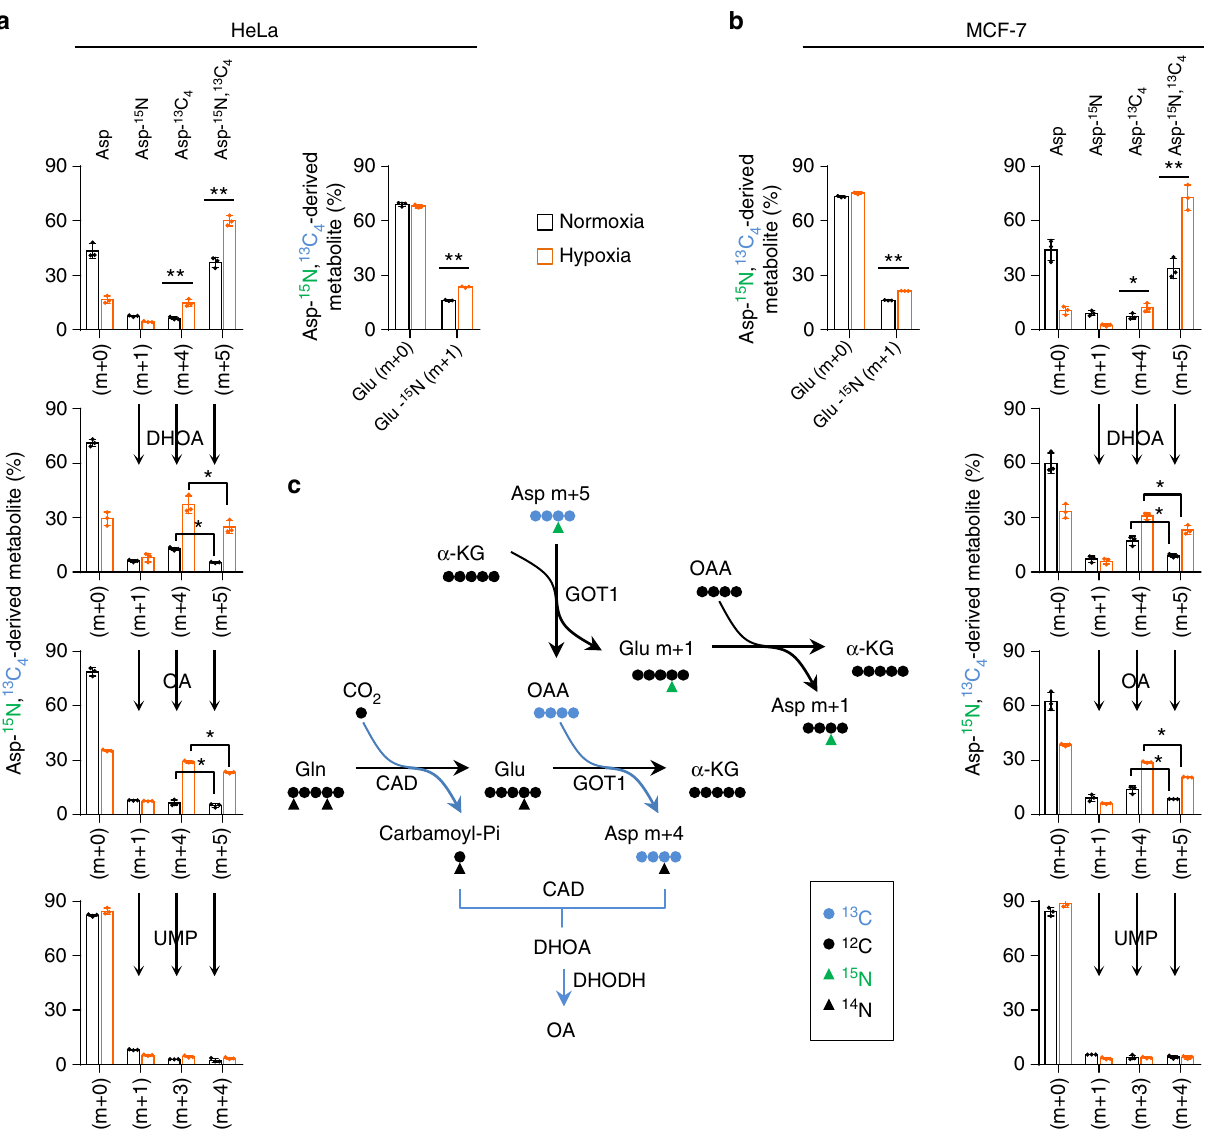
Fig. 4 Promotion of aspartate to pyrimidine precursors under hypoxia. a , b Mass isotopomer analysis of aspartate, glutamate, dihydroorotate, orotate, and UMP in MCF-7 and HeLa cells cultured with the medium containing 10 mM of 13 C 4 , 15 N-aspartate for 8 h under hypoxia or normoxia. Values are the means ± SEM of three independent experiments. * p < 0.05; ** p < 0.01 (Student ’ s t -test). c A schematic to show the metabolic fl ux of 13 C 4 , 15 N-aspartate in the biosynthesis of aspartate, glutamate, dihydroorotate, and